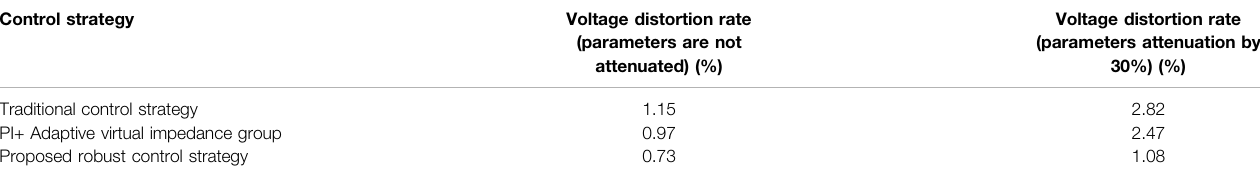
Voltage distortion rate (parameters attenuation